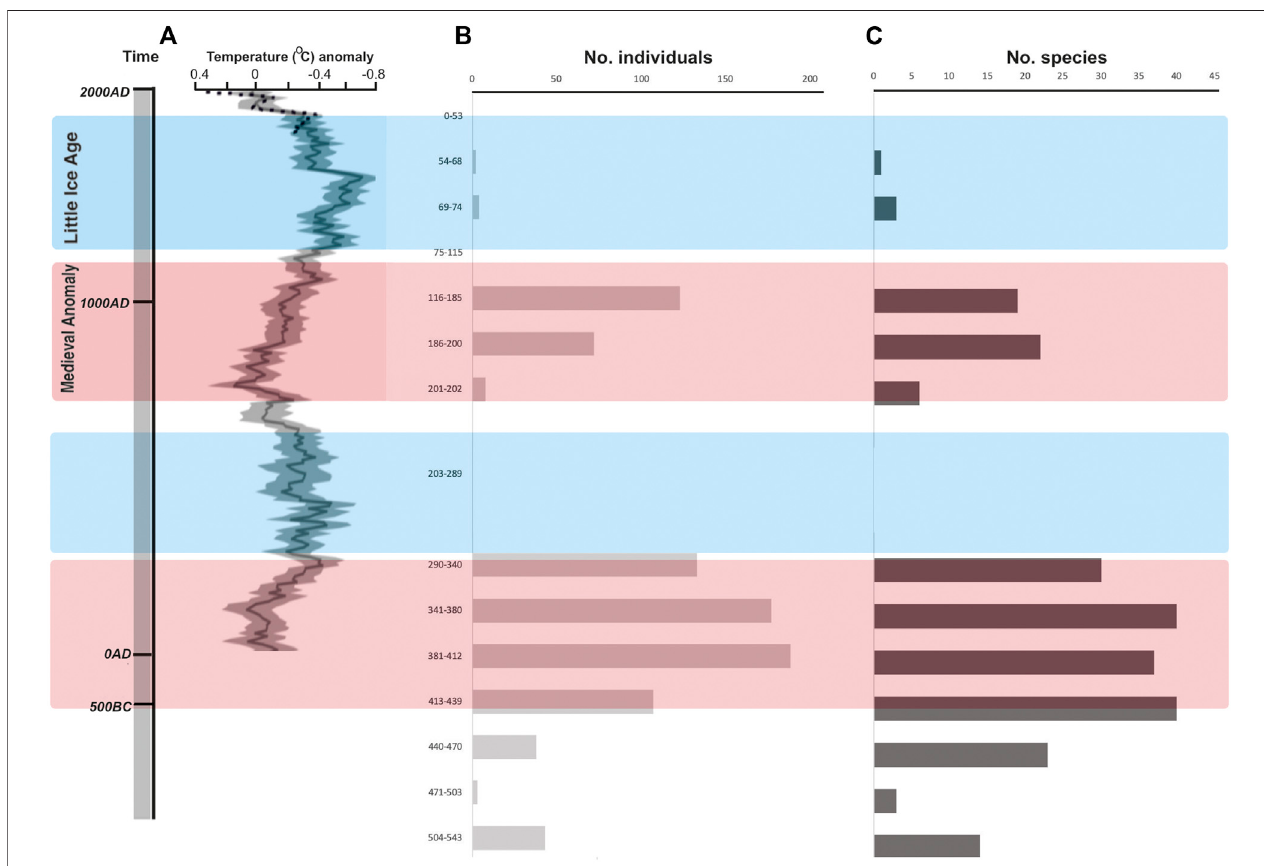
FIGURE 9 | Distribution of the oribatid mites ’ abundances (B) and diversity (C) in the Zaton3 pro fi le and the corresponding temperature anomaly (A) from PAGES 2k Consortium, 2013). Warmer (red) and colder (blue) periods alternate along time.